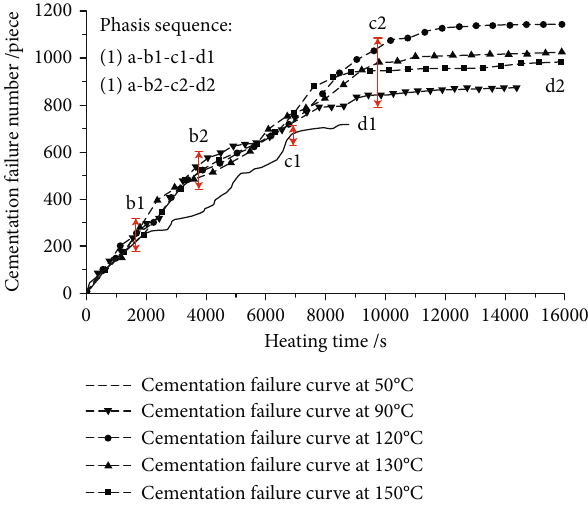
Figure 11: Cementation failure curves of sample model at di ff erent temperatures during temperature